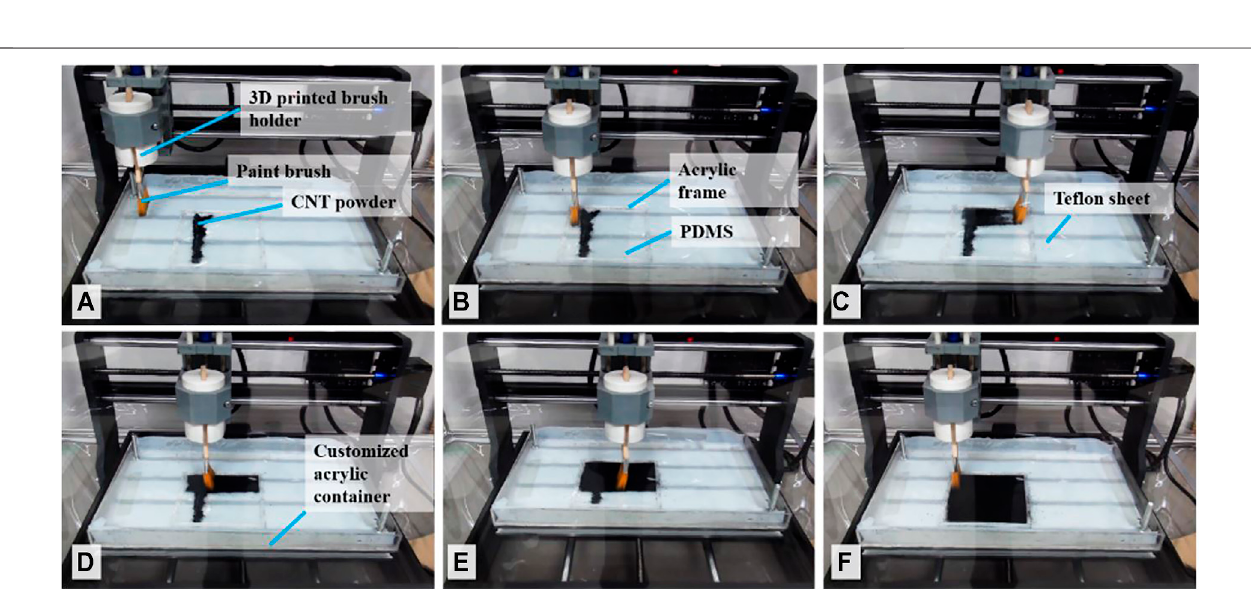
Frontiers in Robotics and AI |